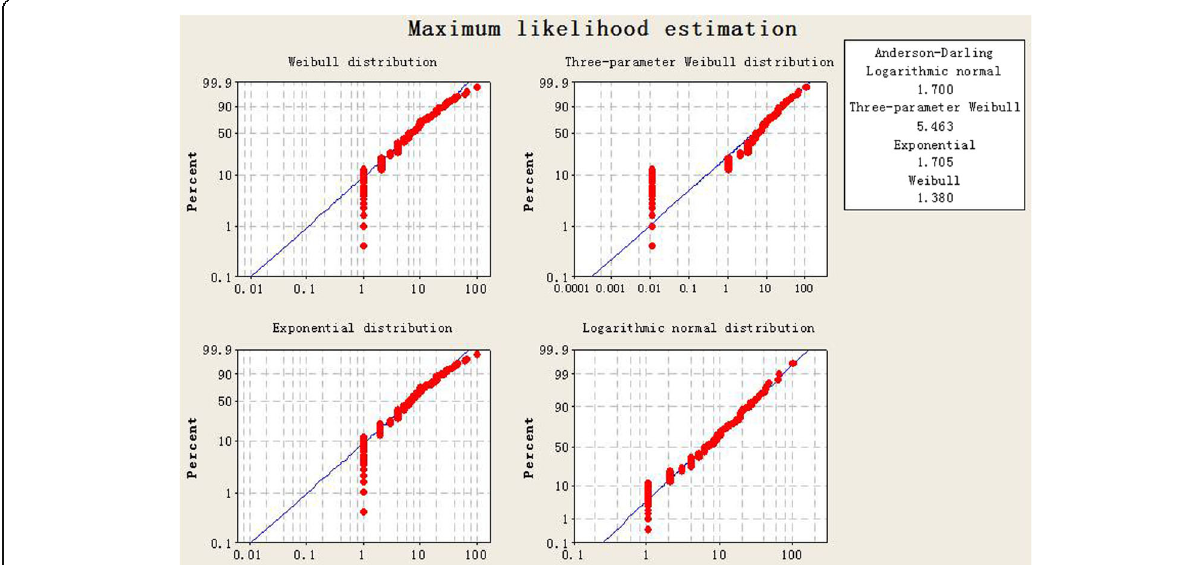
Fig. 4 Degree of fitting of the service life distribution of traction